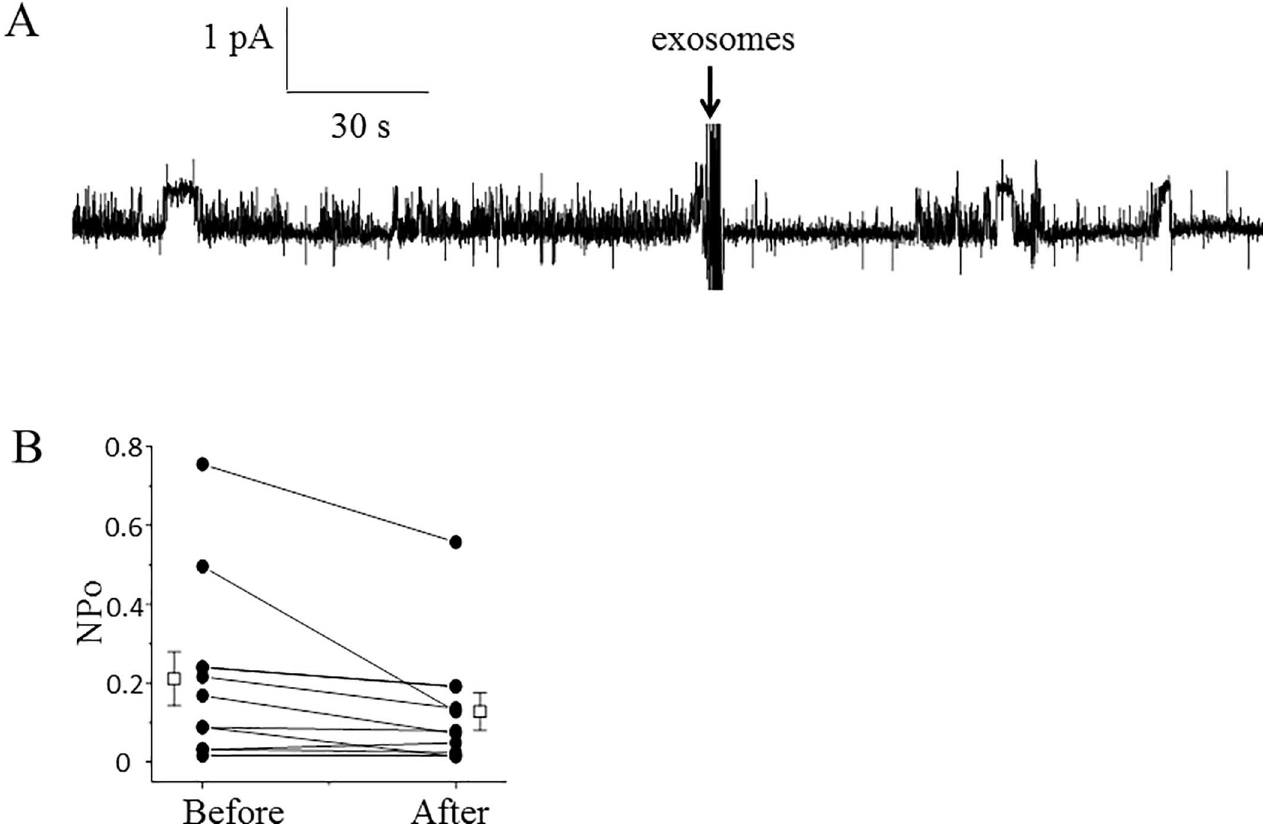
Fig 9. Effect of exosomes isolated from conditioned media on the basolateral side of LLC-PK1 cells on ENaC activity in Xenopus 2F3 cells. (A): representative single-channel recordingusing the cell-attachedconfiguration shows no appreciable change in ENaC activity after applicationof basolateralplasma membrane LLC-PK1 exosomes to the apical side of Xenopus 2F3 cells. The dashedlines denote open and closed levels (o, open and c, closed). The number of current levels represents the number of channelsin the patch. The arrow indicatesthe time point at which the exosomes were appliedto the cells. (B): summary line graph showingthe open probability( P o ) of ENaC did not change after applyingexosomes to the apical surface of Xenopus2F3 cells. Each point representsthe mean ± s.e. and the data shown are from 10 separate patches (N = 10); P =